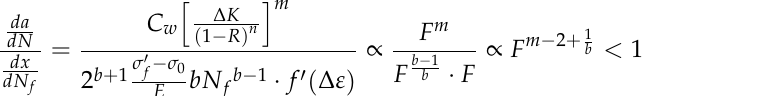
Figure 17. The boundary between crack initiation and propagation and its influencing factors. ( a ) The solution of the boundary and its relationship with nominal stress; ( b ) Influence of external load on